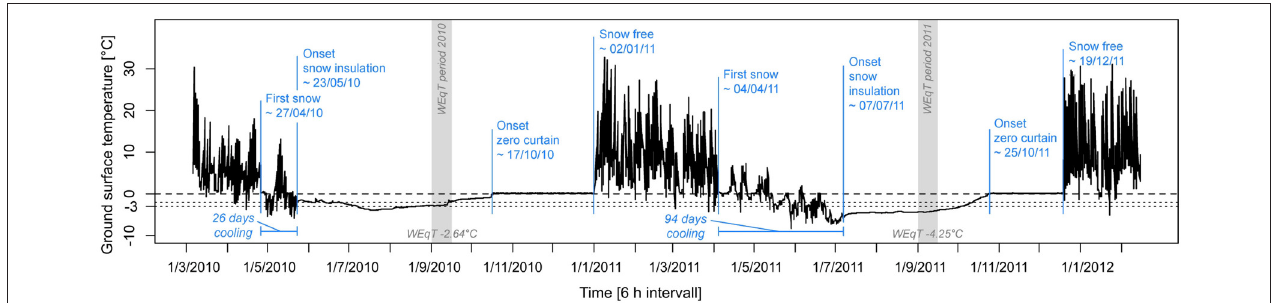
FIGURE 8 | Twenty-three month record of ground surface temperature development at site E5 (for location see Figure 7A), illustrating the influence of snow cover conditions in early winter on winter equilibrium temperatures (WEqT). Gray vertical bars signify the WEqT measurement periods; calculated WEqT are given at the bottom of the